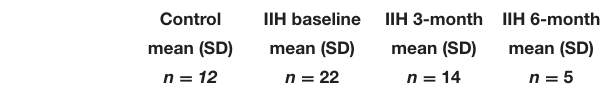
TABLE 2 | Ocular motor and neuropsychology means and standard deviations.